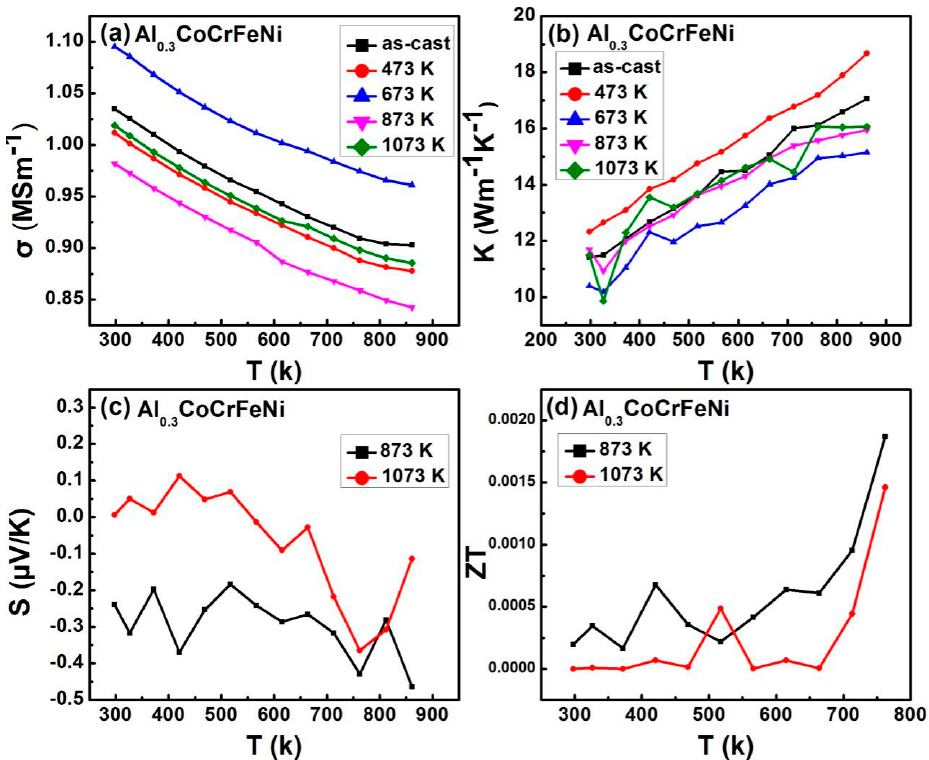
Figure 5. Thermoelectric properties of the annealed Al 0.3 CoCrFeNi alloy. ( a ) Electrical conductivity; ( b ) Thermal conductivity; ( c ) Seebeck coefficient; ( d ) Figure of merit, ZT.